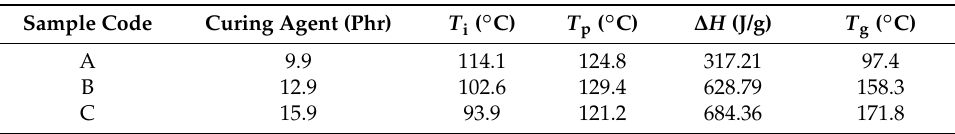
Figure 6. DSC thermograms of various un-cured samples ( left ), and re-scan DSC thermograms of cured samples ( right ) at heating rate of 10 ◦ C/min. Table 2. Thermal characteristics of the curing process of the various samples obtained from DSC analyses at a heating rate of 10 ◦